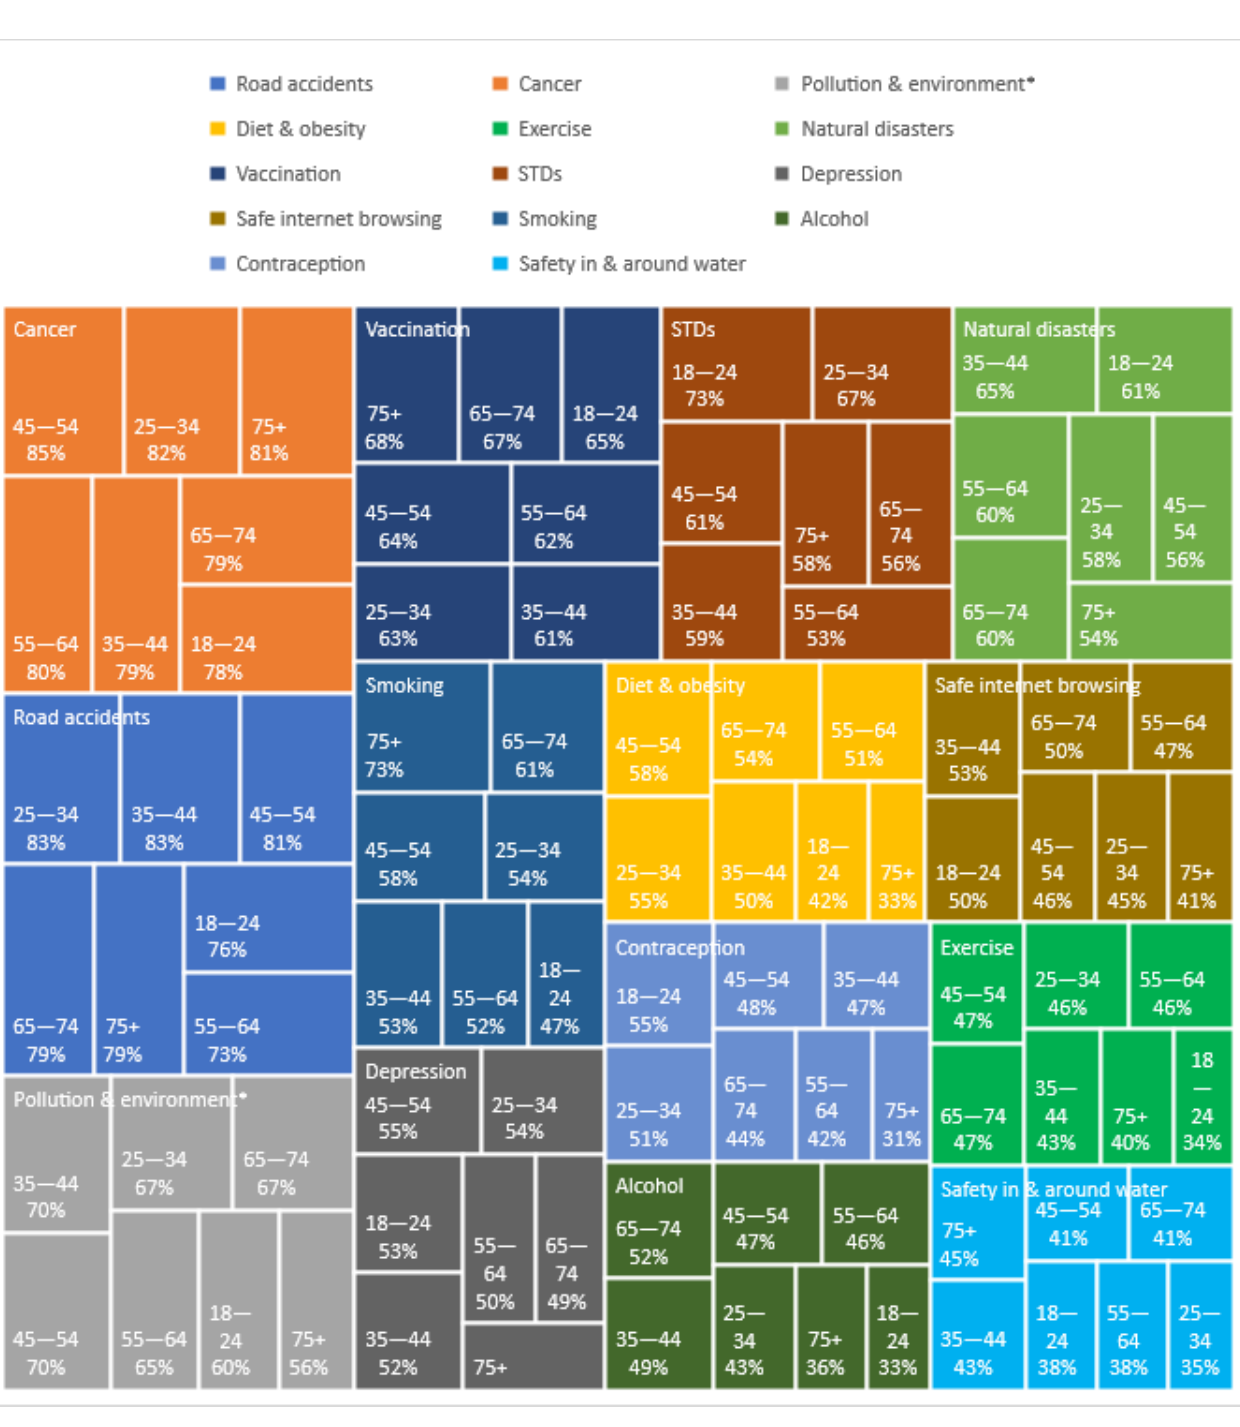
Figure 4. Importance of public health risks by age (showing only “Very important” category); * Pollution and environment stands for air pollution and environmental protection; STDs, Sexually transmitted diseases.